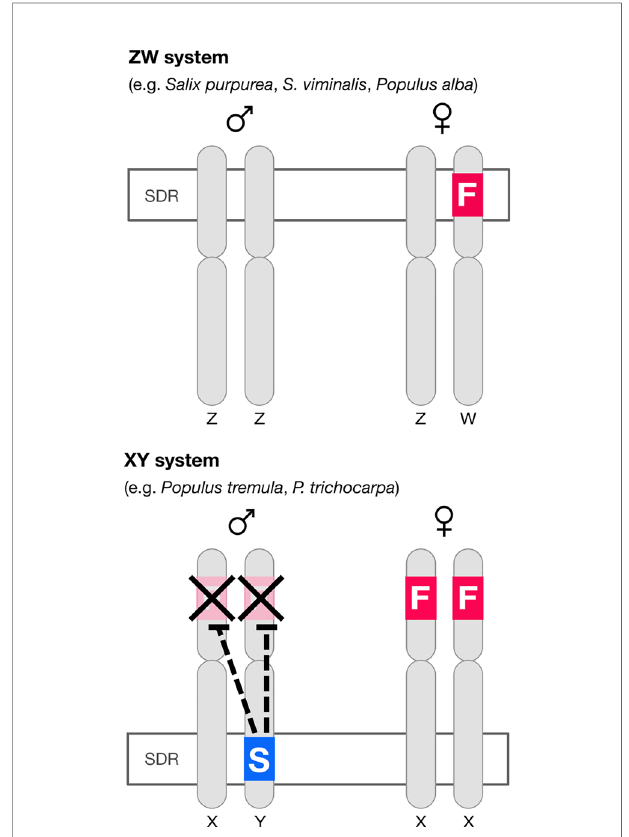
FIGURE 1 | Diagram of the architecture of sex determination in willow and poplar. In at least some willow and one poplar species ( P. alba ) the default developmental pathway is male but a feminizing factor F (the homolog of the cytokinin response regulator ARR17 ) segregates, giving a ZW sex determination system. In most poplar species the default developmental pattern is again male, but both sexes have a copy of the feminizing factor. A “ suppressor of F ” factor (S) segregates, giving an XY system of sex determination. The “ suppressor of F ” consists of an ARR17 pseudogene inverted repeat ( Y ARR17-IR ). This structure leads to the production of sRNA and thence to RNA-directed DNA methylation (RdDM) silencing ARR17 (Müller et al., 2020). The feminizing factor ARR17 is therefore analogous to the masculinizing factor SRY in mammals (except